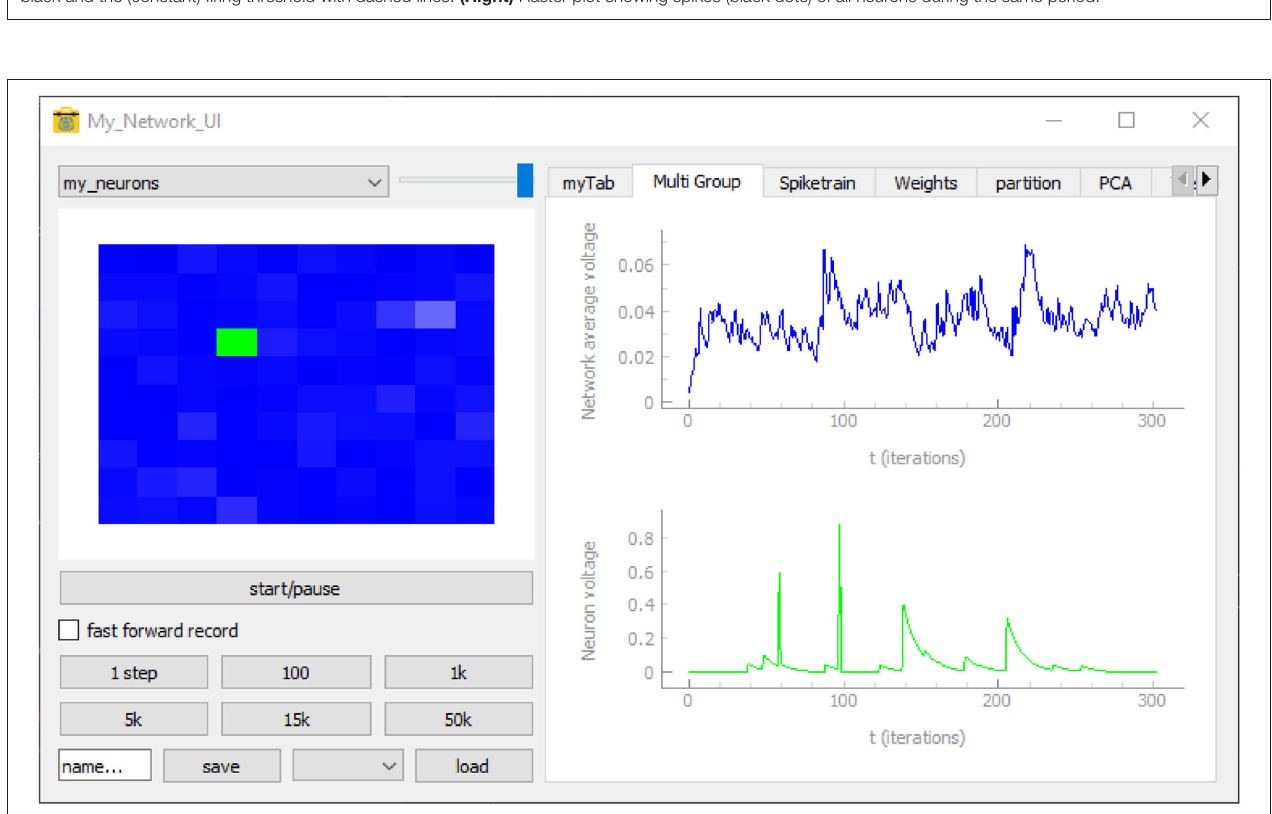
FIGURE 6 | An image of the graphical user interface executed with the code from the User Interface section. The neuron grid on the left displays the activity of each neuron by increasing levels of brightness. The control panel below includes controls to start, pause, save, and load the simulation. The Multi Group tab that has been selected on the right displays the mean activity (blue trace) of the whole neuron group as well as the activity (green trace) of a selected neuron (green pixel in neuron grid) across time. The other (non-selected) tabs listed at the top provide additional forms of live visualizations when selected.